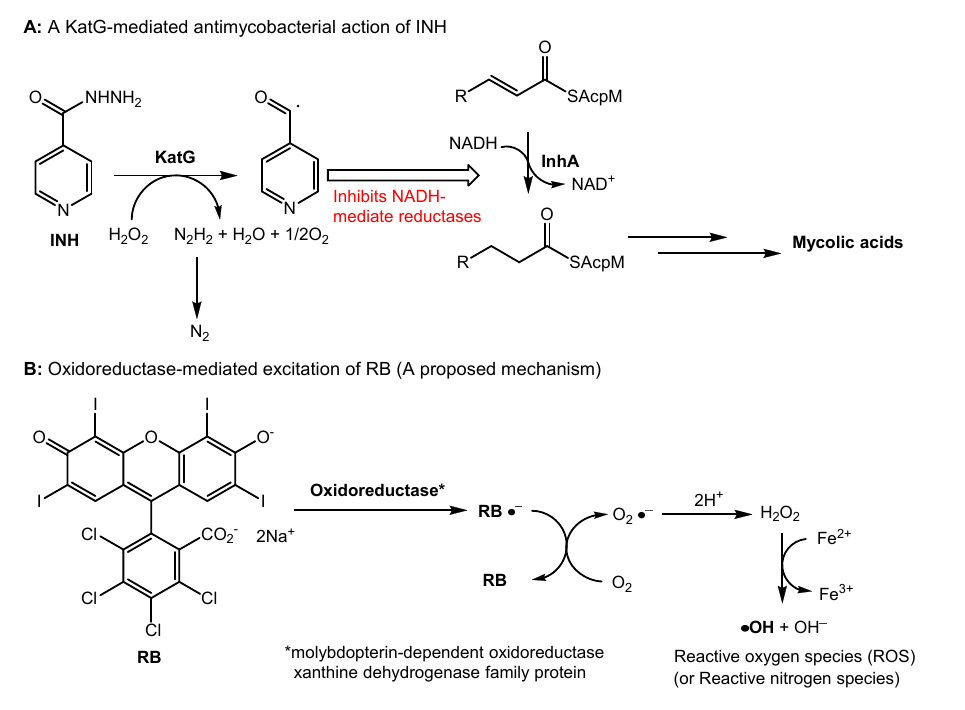
Figure 5. A plausible mechanism of antibacterial activity of RB in dark conditions. ( A ) A mechanism of antimycobacterial activity of INH; ( B ) A proposed mechanism of antibacterial activity of RB in dark conditions.